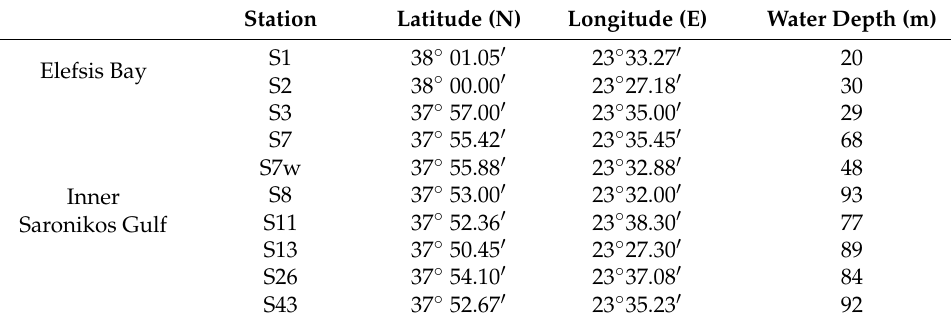
Table 1. Sampling location and water